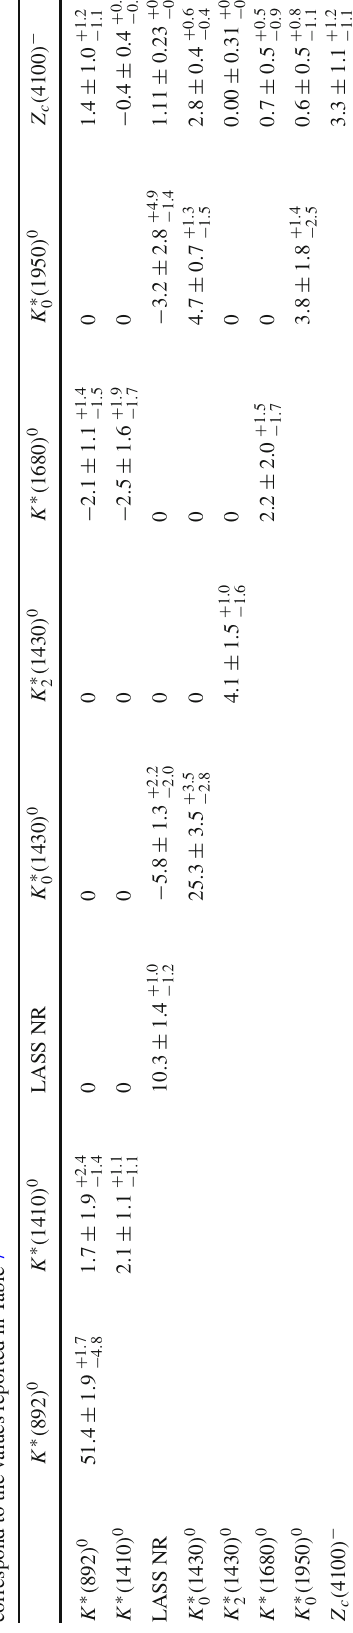
data is obtained when including a charged charmonium-like = resonance decaying to the η c π − final state with m Z − c The fit fractions are reported in Table 7. The fit fractions for resonant and nonresonant contributions are converted into quasi-two-body branching fractions by multiplying by the B 0 → η c K + π − branching fraction. The corresponding ing fraction is compatible with the world-average value [8], tion. The values of the interference fit fractions are given in The significance of the Z c ( 4100 ) − candidate is more than three standard deviations when including systematic uncer- tainties. This is the first evidence for an exotic state decay- ing into two pseudoscalars. The favoured spin-parity assign- ments, J P = 0 + and J P = 1 − , cannot be discriminated once systematic uncertainties are taken into account, which prohibits unambiguously assigning the Z c ( 4100 ) − as one